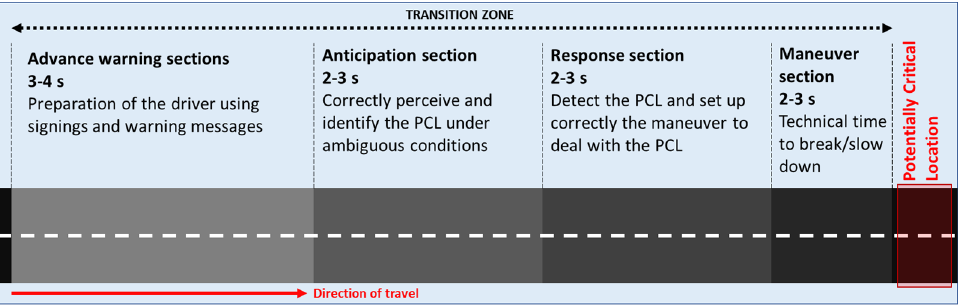
Figure 1. Definition of the transition zone as described by PIARC [25].